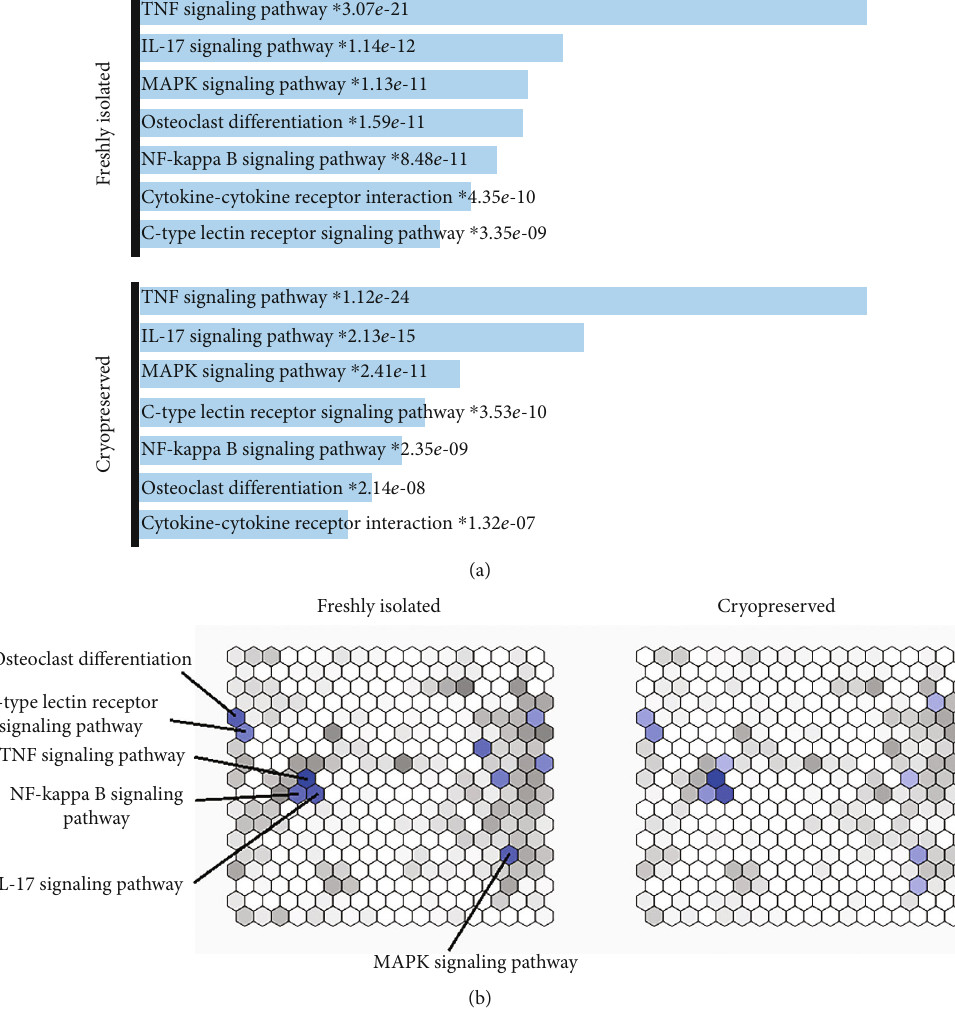
Figure 5: Gene set enrichment analysis. Signi fi cantly (adjusted P value < 0.01) upregulated genes in Ec N compared to control samples originating from fresh and cryopreserved colonoids, respectively, were examined for their similarity to gene sets of the KEGG 2019 Mouse library via Enrichr gene set enrichment analysis web server. (a) Top enriched terms in the KEGG 2019 Mouse library, with P values. Asterisk symbolizes the term has an adjusted P value < 0.05. (b) Each hexagon represents one gene set from the KEGG 2019 Mouse library. The brighter the blue color is, the more similar and, therefore, signi fi cant the speci fi c gene set. Hexagons that are grouped together represent similar gene